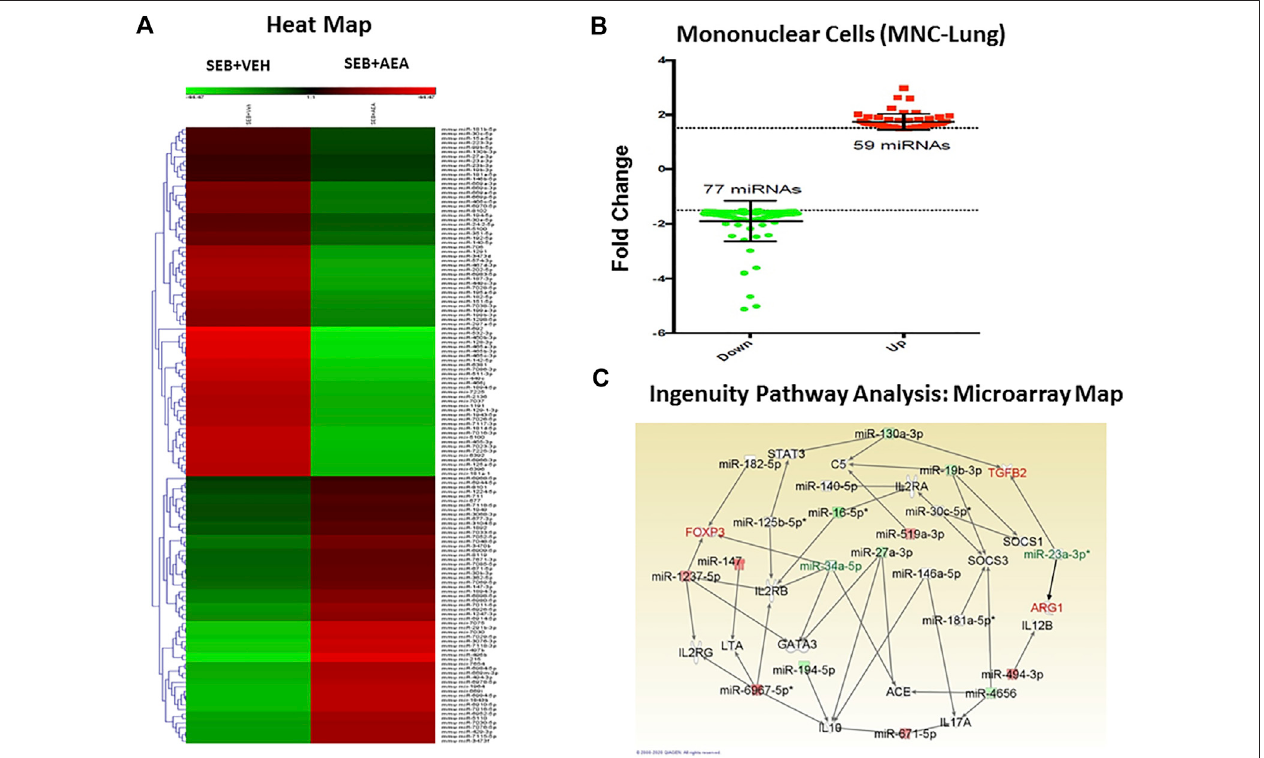
FIGURE5| AEAaltersmiRNAexpressioninthemononuclearcellsisolatedfromthelungsofSEBinjectedmice.MiceweretreatedwithSEBandAEAasdescribed in Figure 1 legend. Isolated mononuclear cells of the lung were screened for miRNA expression as described in methods (A) . The heat map that shows all of the altered and unchanged miRNAs in the VEH + SEB and AEA + SEB groups. (B) Diagram of miRNAs with 1.5 fold change showing 59 miRNAs upregulated while 77 miRNAs downregulated. (C) Networking of the miRNAs with their targeted genes including anti-in fl ammatory genes, the map showing the main miRNAs including miRNA 23a-3p targeting ARG1 and TGF β 2 gene while miRNA 34a-5p targeting FOXP3